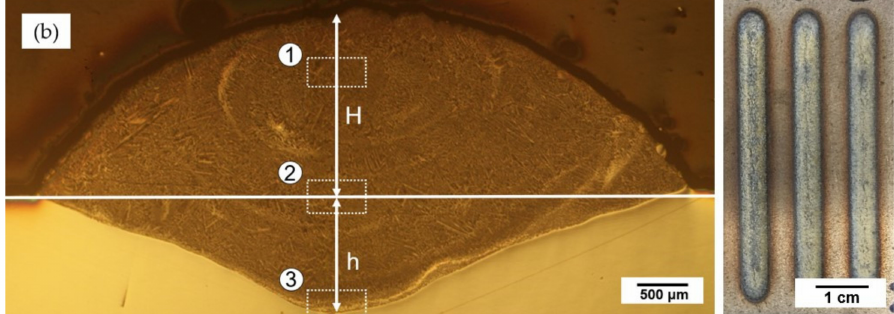
Figure 5. Overview of the laser cladding track and cross-section morphologies of the cladding layer: ( a ) 55 NiTi powder cladding layer; ( b ) 55 NiTi + 5 Ni powder cladding layer.